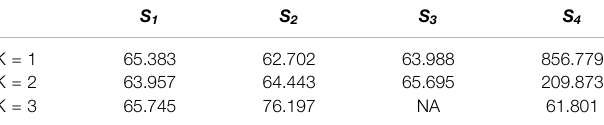
TABLE 2 | PMSE values for different